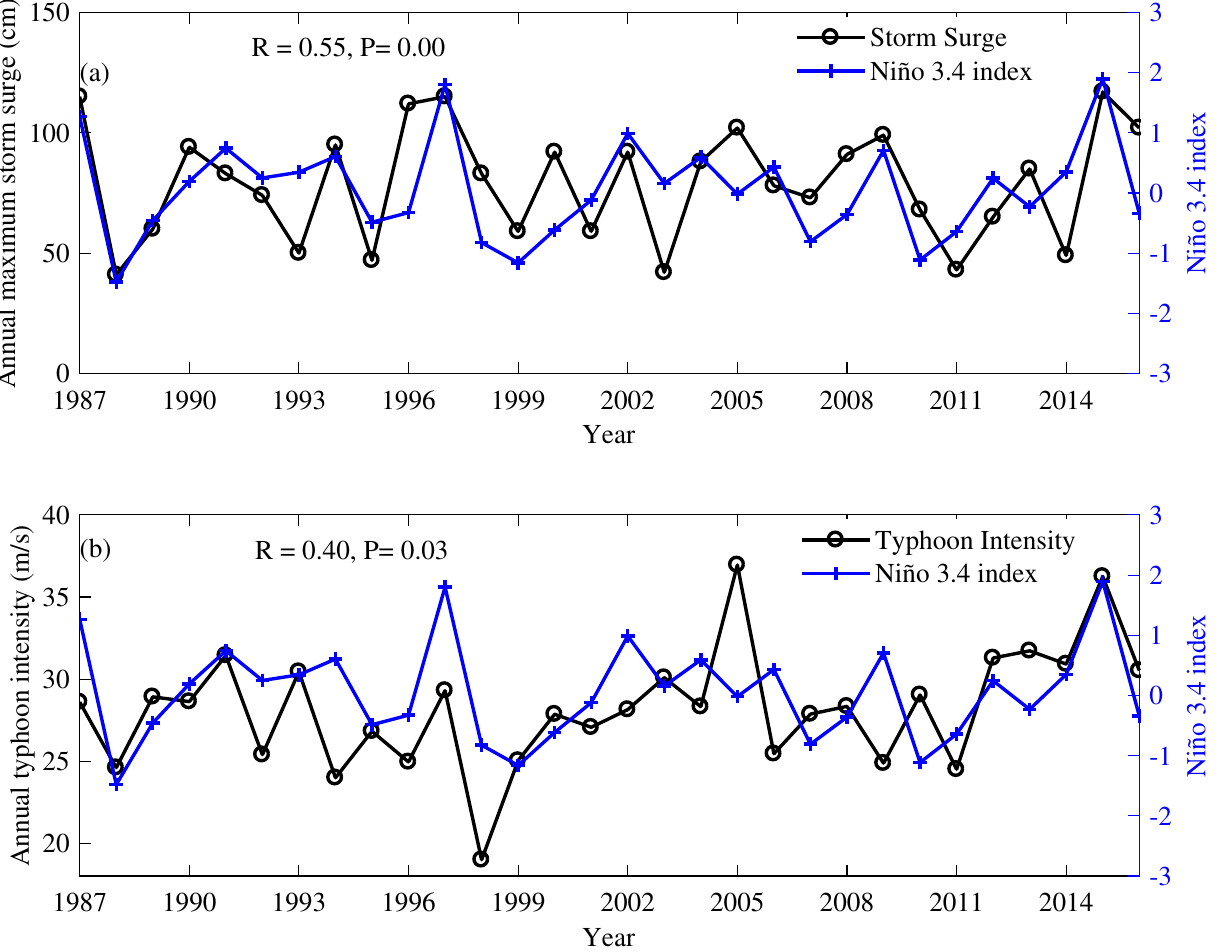
Figure 4. Time series of ( a ) the AMTSS at Pingtan and ( b ) the annual-mean typhoon intensity at its landfall, compared with Niño-3.4 index averaged over